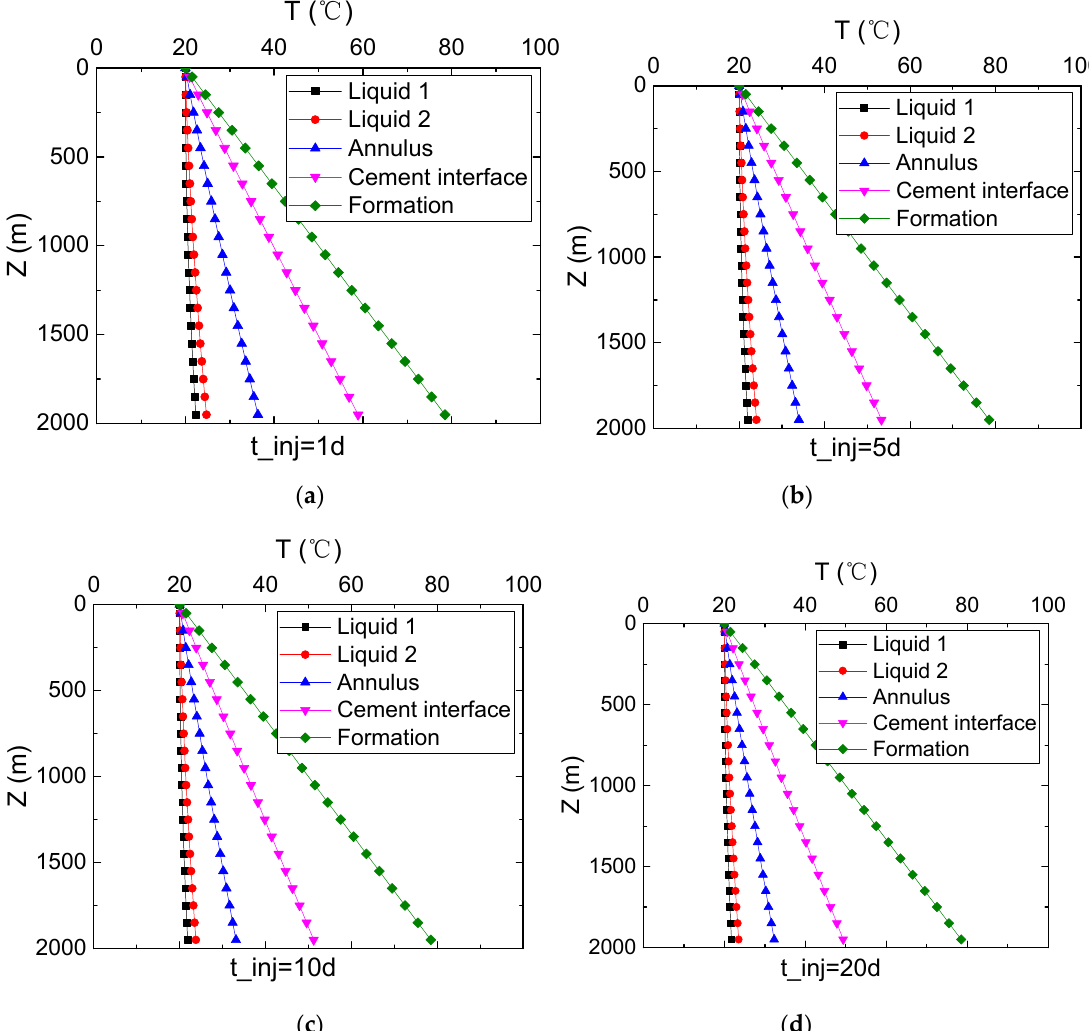
Figure 7. Temperature distribution in downhole for different layers. The influence of injecting time for inner layer is weaker than the outer layer. The injecting time are: ( a ) 1 d, ( b ) 5 d, ( c ) 10 d, ( d ) 20 d.